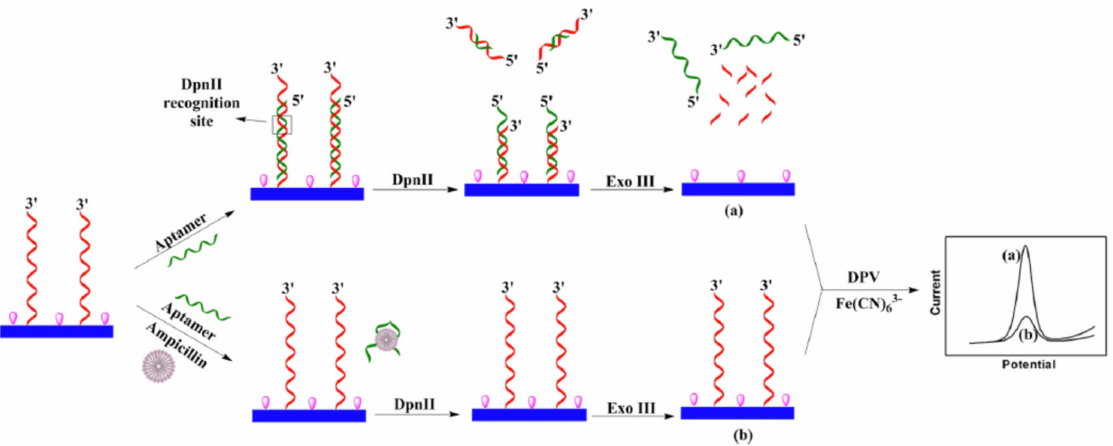
Figure 19. Electrochemical aptasensor for ampicillin detection based on the protective effect of aptamer-antibiotic complex towards DpnII and Exo III digestion. Reprinted from reference [69] with permission from Elsevier.